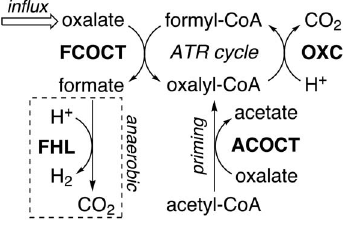
Figure 8. ACOCT primes the oxalate-induced ATR cycle. YfdW and YfdU appear to be required for the oxalate-induced ATR [19]. Arrows indicate the expected physiological direction; only OXC catalyzes an irreversible reaction [13,73]. ACOCT enables the synthesis of oxalyl-CoA when formyl-CoA and formate are unavailable (e.g., aerobic conditions). The aerobic fate of formate is unclear; the FHL reaction in the dotted box is associated with anaerobic conditions. Oxalate/formate antiport is not detected in E. coli [19]. ACOCT and FCOCT could also work together to support the oxalate-catalyzed interconversion of formyl-CoA/acetate and acetyl-CoA/formate (not shown).